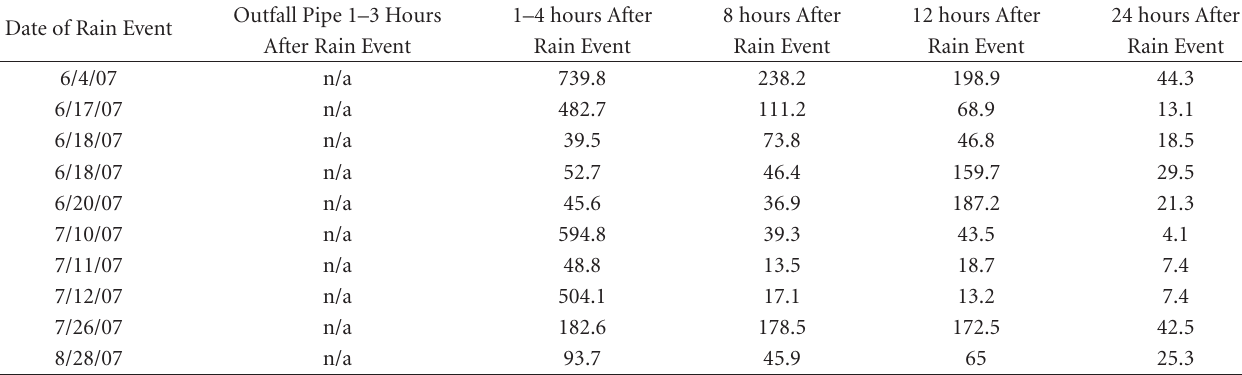
Table 8: E. coli concentrations ( ∗ MPN/100 mL) from beach water collected at time intervals following the triggering of a rain event at Sunset Park beach. While there was a significant di ff erence between the mean E. coli concentration during a rain event and the seasonal mean E. coli concentrations for this beach using ANOVA (Table 1), Sche ff e matrix analysis showed no significant di ff erence between E. coli concentrations at each sampling times after a rain event and the seasonal E. coli mean. . If rainfall was su ffi cient to trigger multiple rain event notifications on one day, then multiple events were